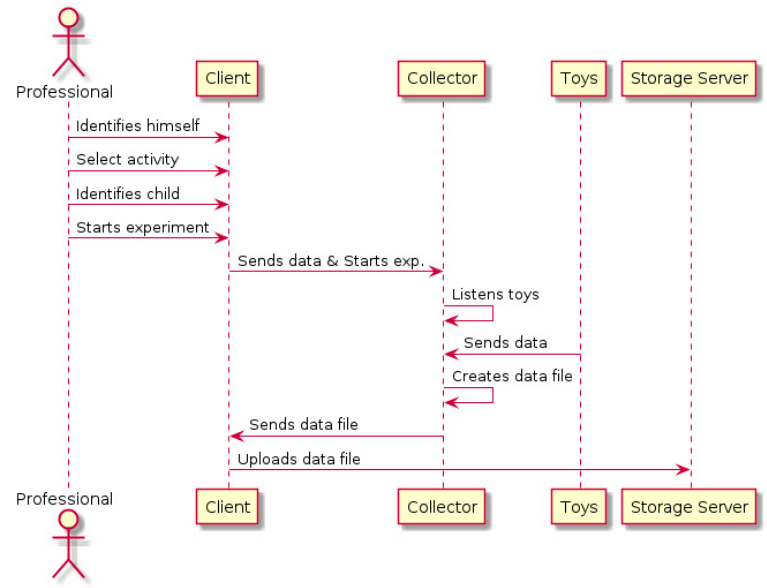
Figure 21. Data recollection process.